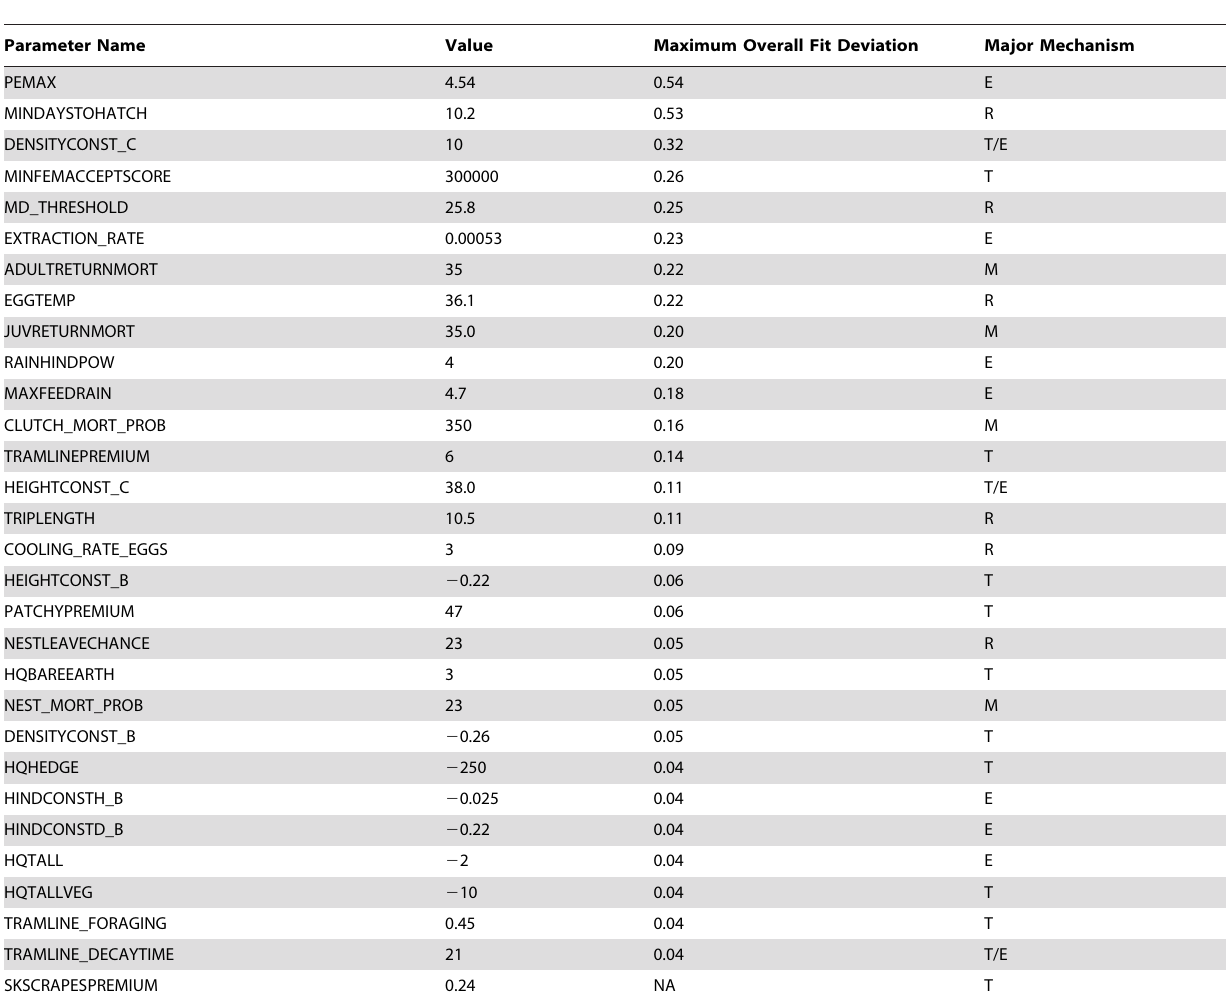
Table 3. Input parameters modified during the pattern-oriented modelling procedures and the subsequent fitted values, sensitivity analyses with the overall fit statistic, and the biological mechanisms that each parameter is related to: E =Energetics, R=reproduction, M =Mortality and T =Territory